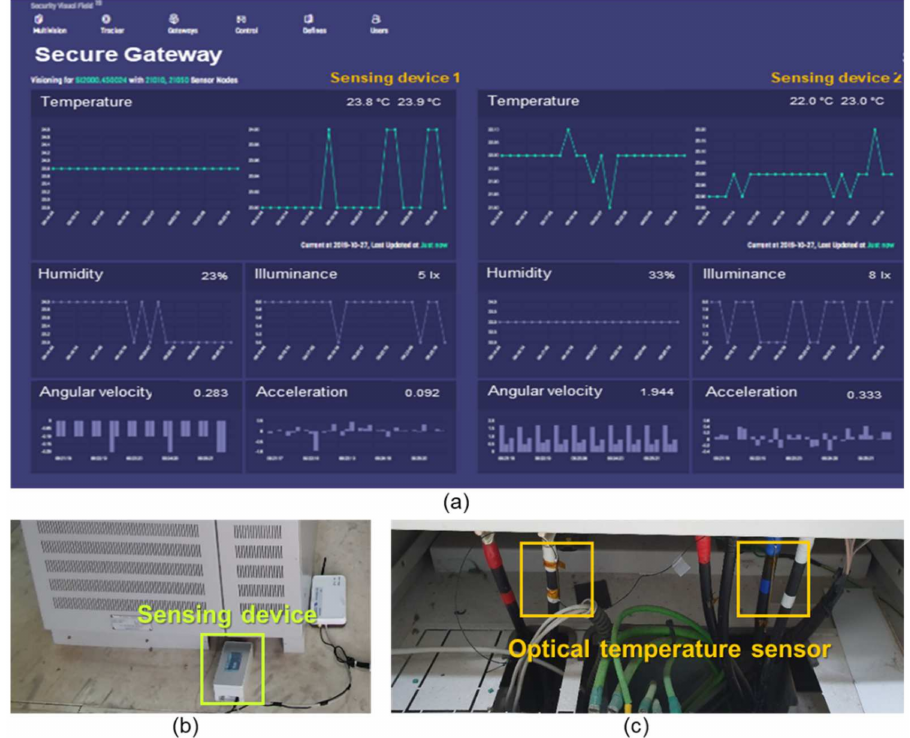
Figure 11. ( a ) Real-time facility monitoring using the developed control platform at the facilities. ( b ) Installed sensing devices and gateway. ( c ) Optical temperature